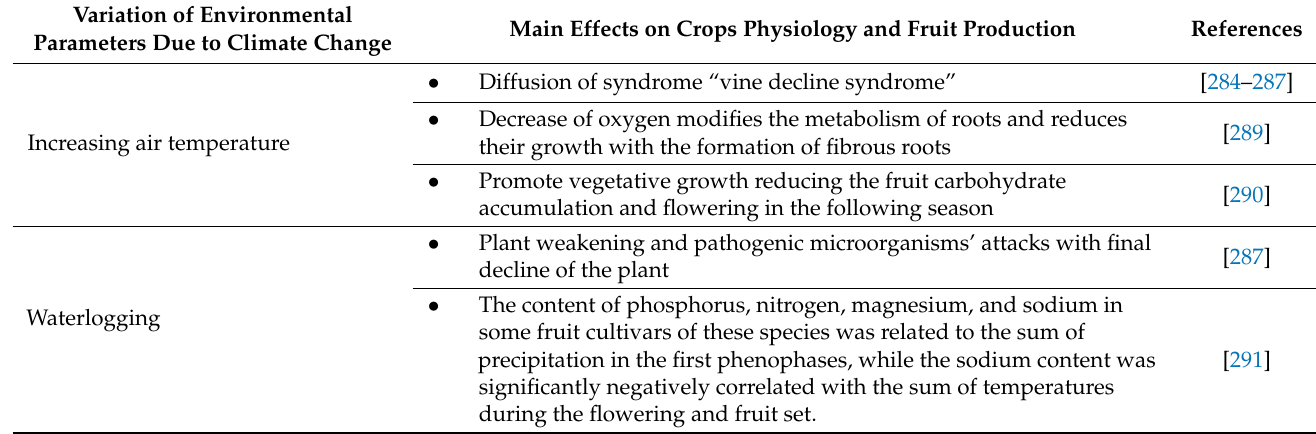
Table 7. Summary of principal effects of environmental conditions variation on kiwi species.